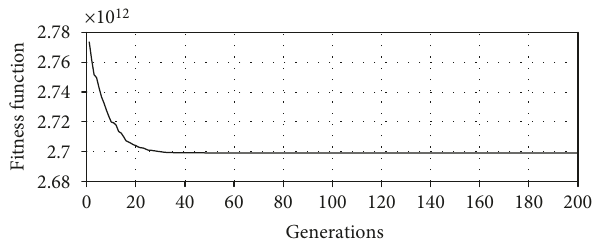
Figure 18: ff harmonic evolution of the fi tness function of strategy 3 through generations.